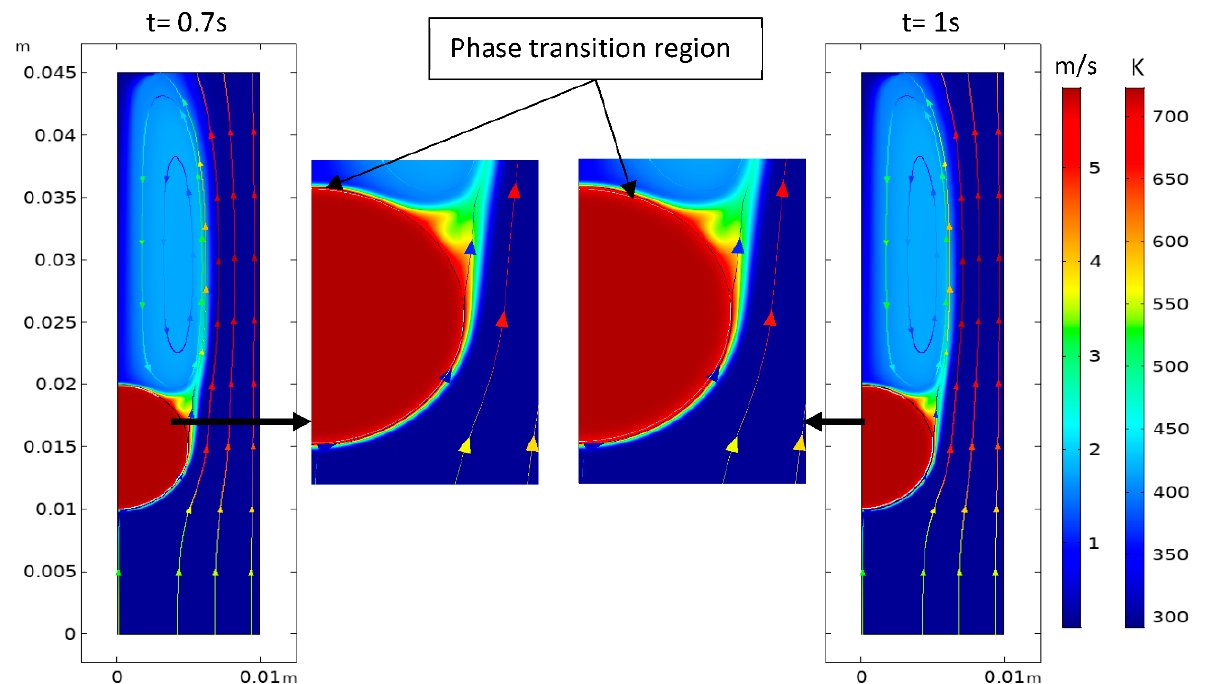
Figure 8. Temperature distribution of N 2 and the droplet (CuCl) domain with a droplet radius of 0.005 m.